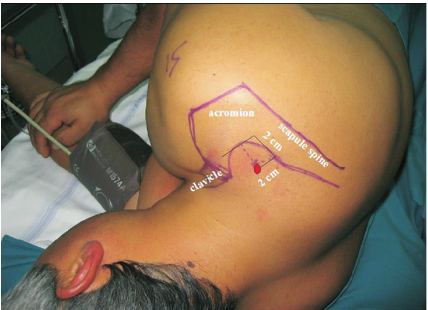
Figure 10: Checcucci technique for the suprascapular nerve block. Needle insertion is 2cm medial to the medial border of the acromion and 2cm cephalad to the superior margin of the scapular spine (Checcucci et al. [4]). (Reprinted with permission from